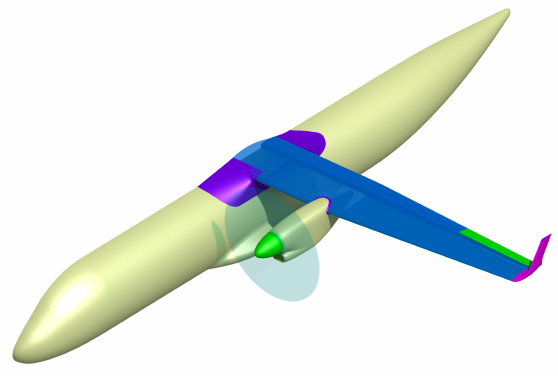
Figure 7. CAD surfaces of the reference